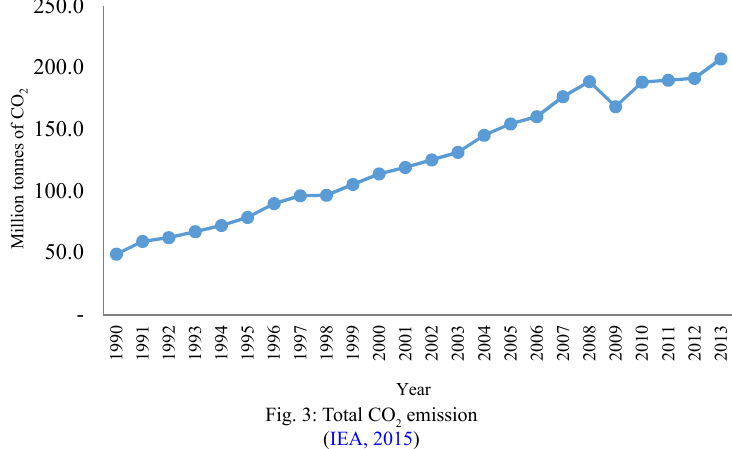
Fig. 3: Total CO emission 2 (IEA, Fig. 3: Total CO 2 emission